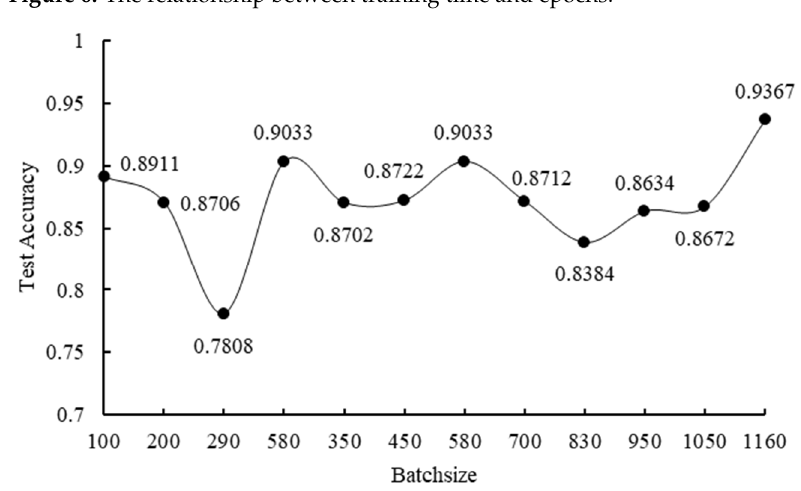
Figure 7. The relationship between test accuracy and batch size.